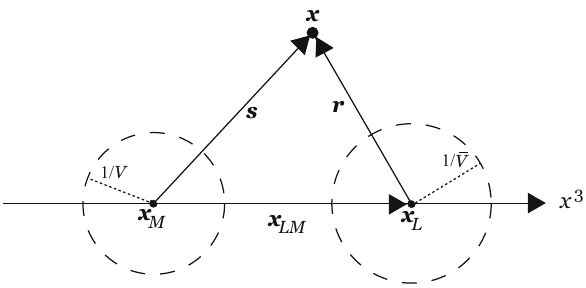
Fig. 8 The coordinates of a KvBLL caloron in terms of the two con- stituent dyons L , M